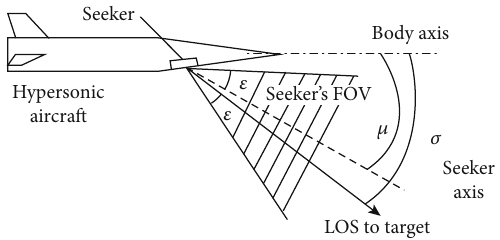
Figure 1: Hypersonic missile with an o ff -axis seeker. Figure 2: 2D angular con fi guration of the o ff -axis strapdown seeker.